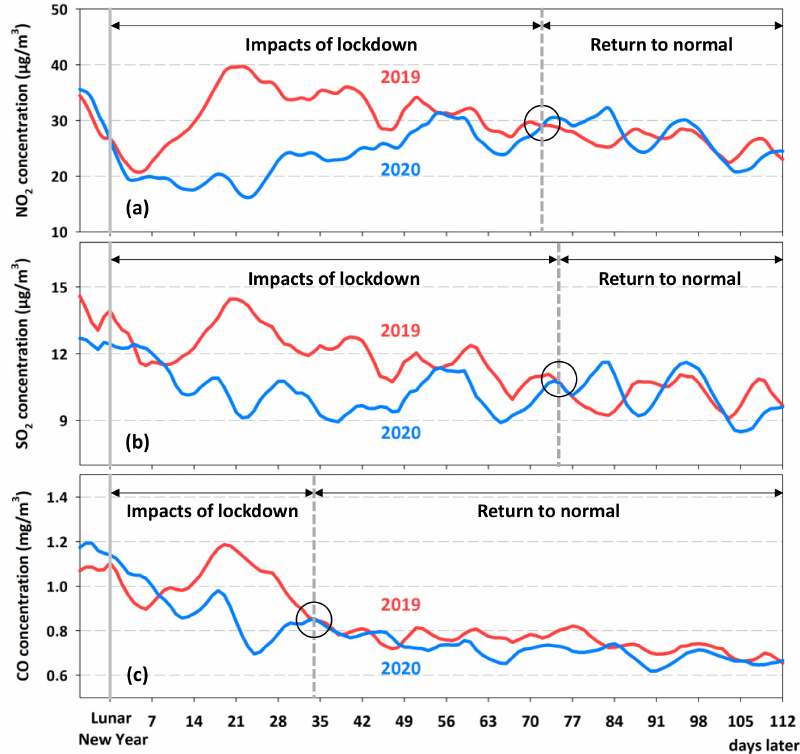
Figure 5. Time series of the 7d moving averages of daily population-weighted surface (a) NO 2 , (b) SO 2 , and (c) CO concentrations after the Lunar New Year of 2019 and 2020 in China. The black circle in each panel shows the turning point when the gaseous pollutants began to return to their normal levels.